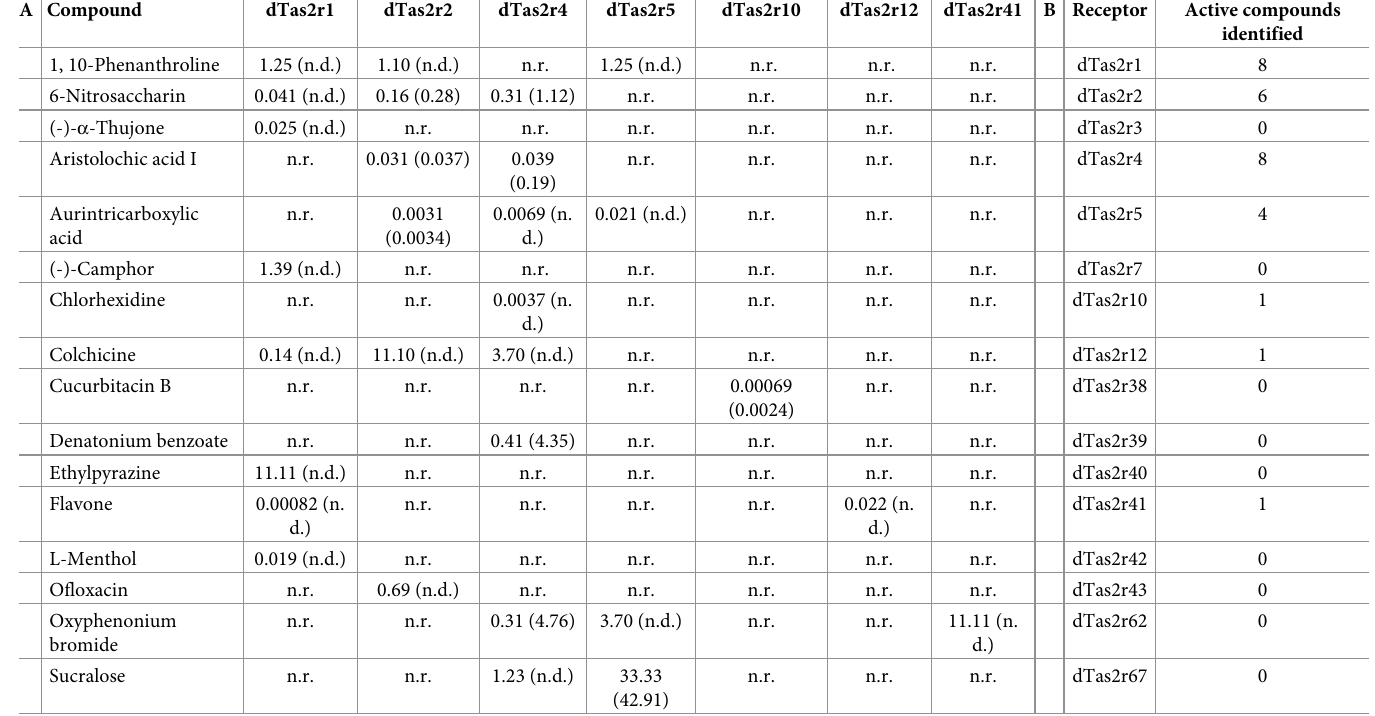
Table 1. Confirmed agonists of dTas2rs. A) A total of 7 dog Tas2rs were deorphanised with agonists showing specific, concentration-dependent responses. Threshold concentrations were the lowest concentration (mM) giving a significant (Student’s t-test, p � 0.05) difference from the mock cell line. EC 50 values (mM) are given in paren- theses where available (n.r. = no response, n.d. = not determined). B) Total discovered agonist counts for all